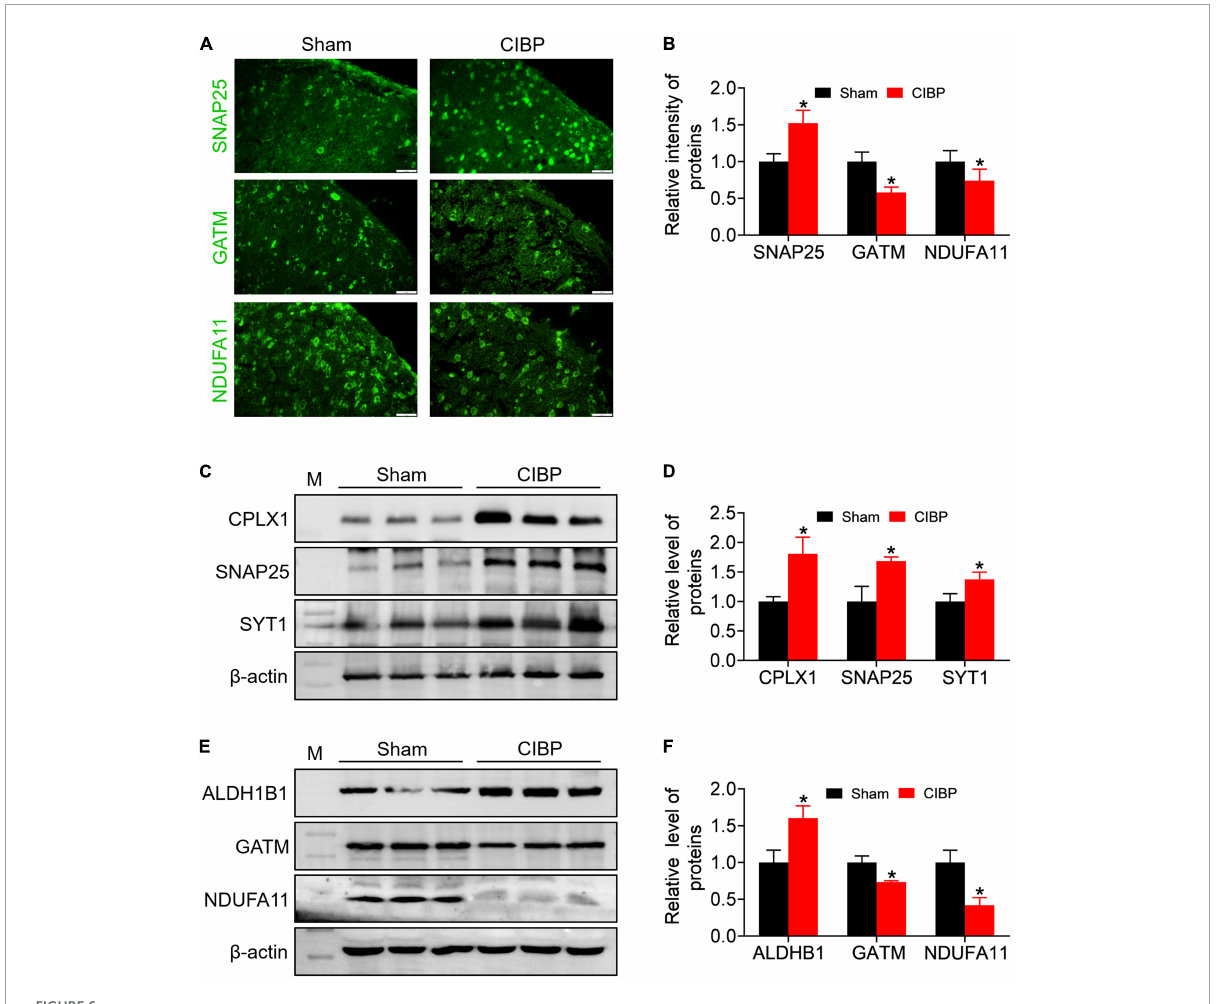
FIGURE6 Validation of synaptic- and mitochondrial-related proteins using immunofluorescence and Western blot assay. (A,B) Representative immunofluorescence staining images (A) and quantitative analysis (B) for SNAP25, GATM, and NDUFA11 in the spinal cord. Scale bar = 20 µ m. Data were expressed as the mean ± SD ( n = 3 mice/group). * p < 0.05 vs. sham group. (C,D) Representative Western blot bands (C) and quantitative analysis (D) of CPLX1, SNAP25, and SYT1 protein in the spinal cord. Data were presented as mean ± SD ( n = 3 mice/group). * p < 0.05 vs. sham group. (E,F) Representative western blot bands (E) and quantitative analysis (F) of ALDH1B, GATM, and NDUFA11 protein in spinal cord. Data were presented as mean ± SD ( n = 3 mice/group). * p < 0.05 vs. sham